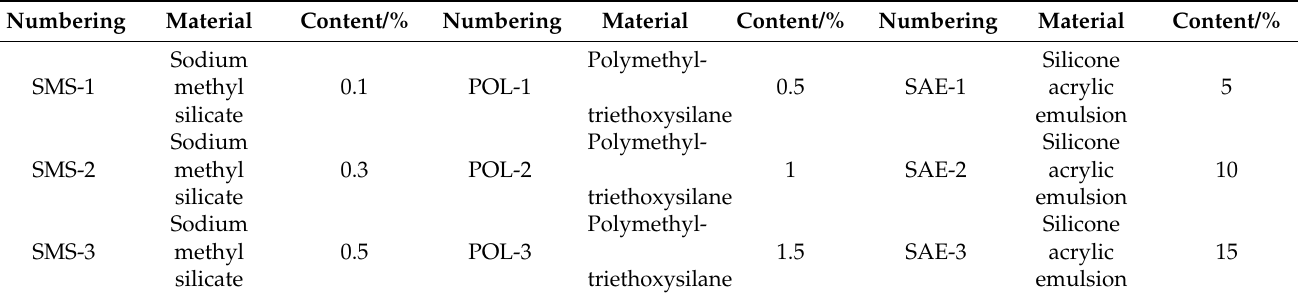
Table 3. Different materials and